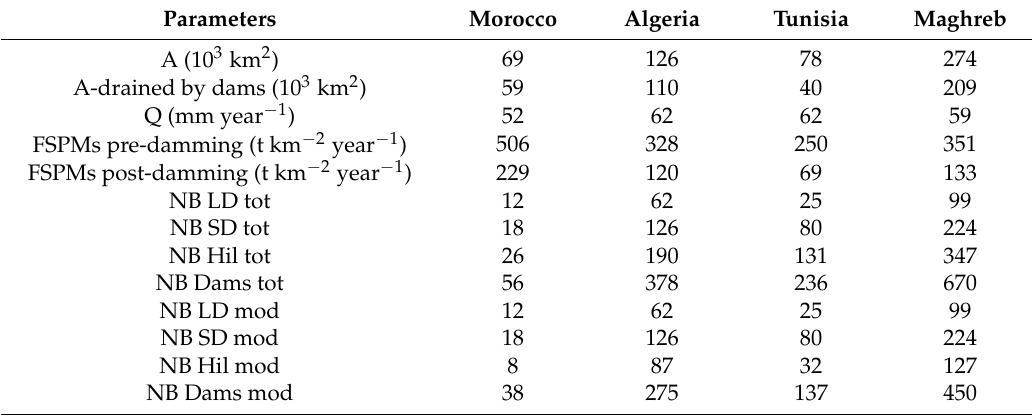
Table 3. Summary of average water and sediment fluxes in the Mediterranean Maghreb Basin (MMB) before and after dam construction, and total number of reservoirs considered in this